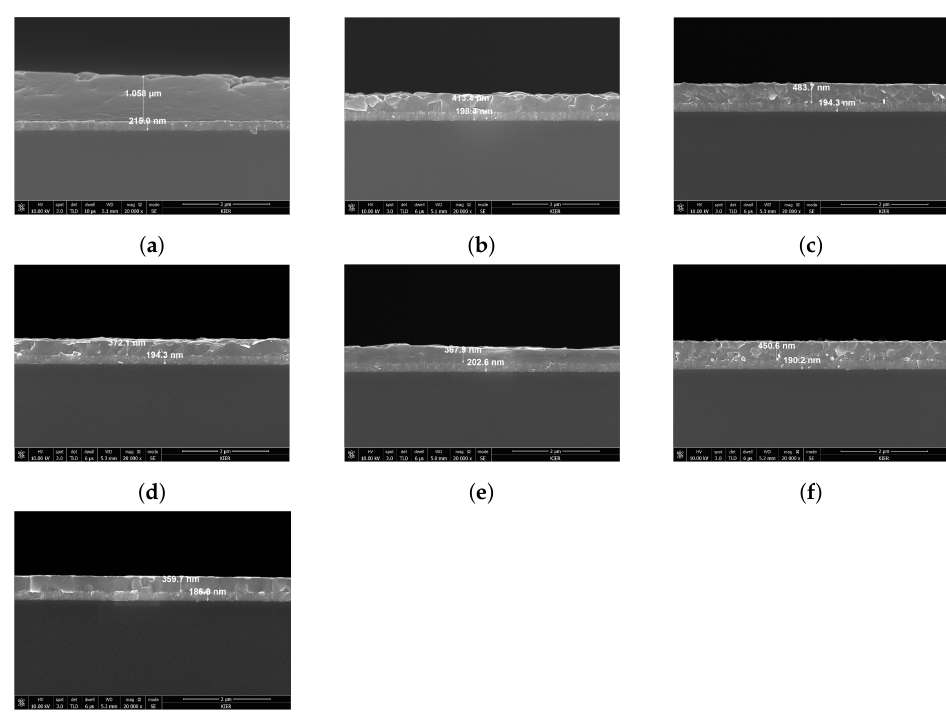
Figure 4. Analysis of the cross-sectional structure of quaternary perovskite specimens using SEM: ( a ) FAPbI 3 , ( b ) FAPbBr 3 , ( c ) FA 0.5 MA 0.5 PbI 3 , ( d ) FA 0.5 MA 0.5 PbI 1.5 Br 1.5 , ( e ) FA 0.5 MA 0.5 Br 3 , ( f ) MAPbI 3 , ( g ) MAPbBr 3 .